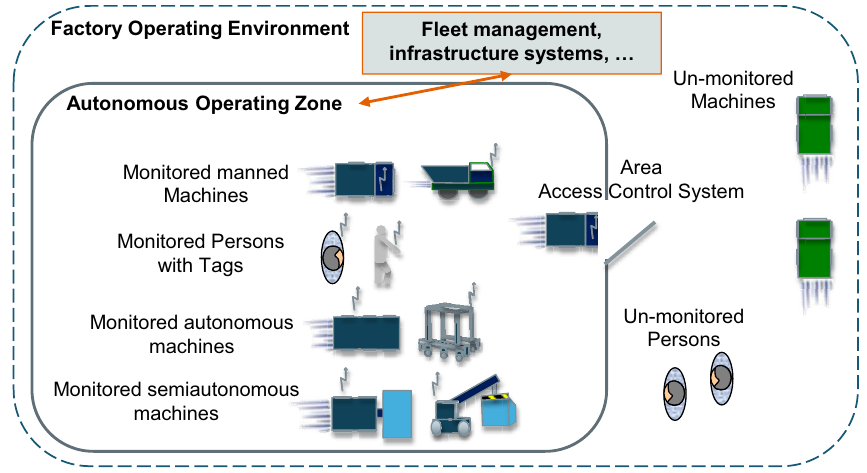
Figure 2: Autonomous/semiautonomous machine system